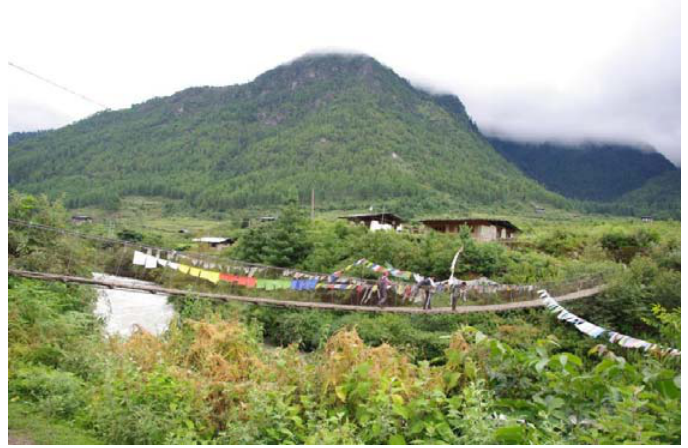
Figure 10. Suspension bridge at Mishi Zampa of Jomolhari